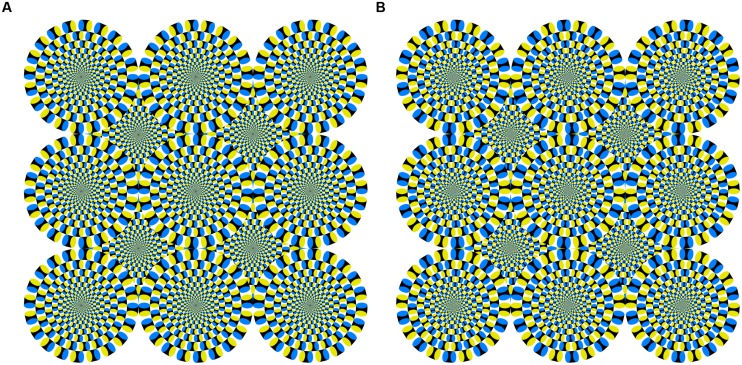
(A) Snake image with illusory motion used in Experiments 1 and 2, and (B) reversed image without illusory motion used in Experiment 2. Both were reproduced with permission from the author (Kitaoka, 2011).